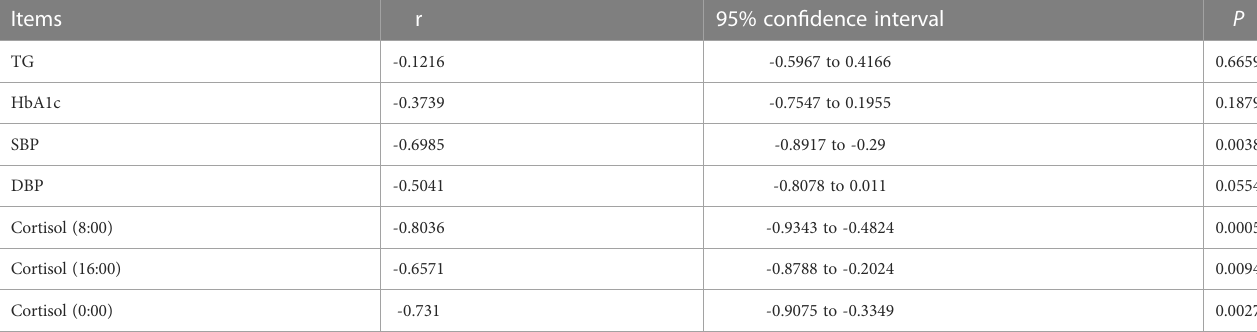
TABLE 2 Spearman analysis of propionic acid and clinical indexes.